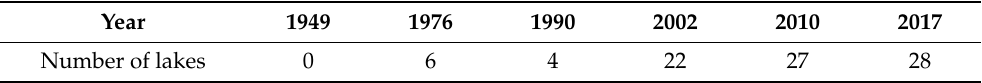
Table 3. Number of lakes in